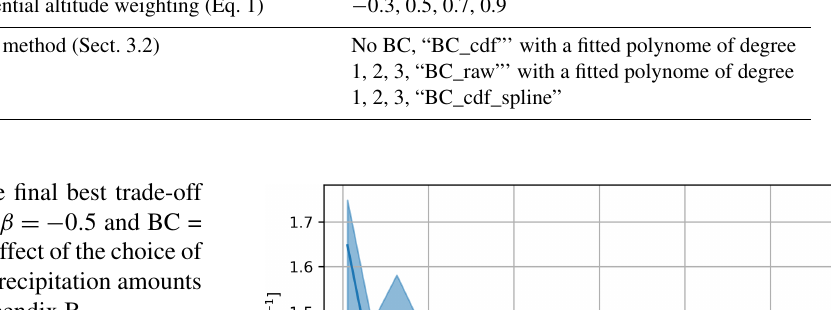
Table 3. List of all hyperparameters used in the RF algorithm, as well as the range of values that were tested. Parameter Meaning Tested values t Number of trees in the random forest 10, 15, 20, 30, 40, 50 d The maximum depth (number of nodes) of the individual trees 10, 15, 20, 30, 40